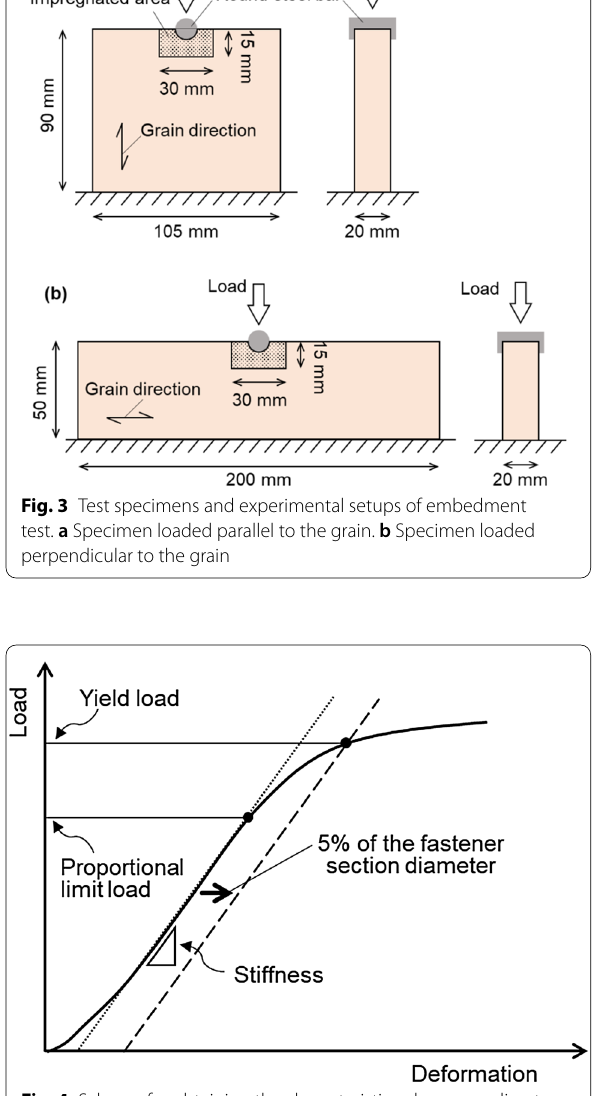
Fig. 4 Schema for obtaining the characteristic values according to ISO 10984-2